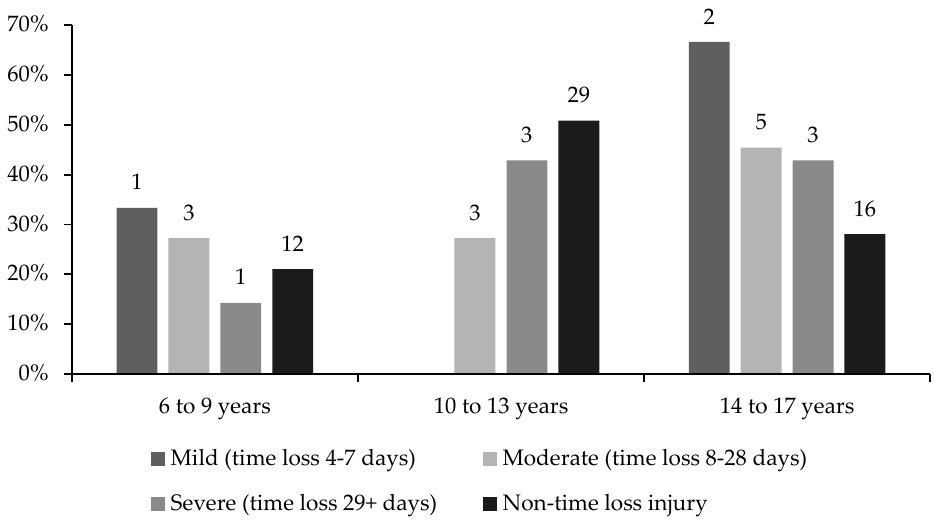
Figure 4. Proportions of mild, moderate, severe and non—time—loss injuries distributed across three age categories.